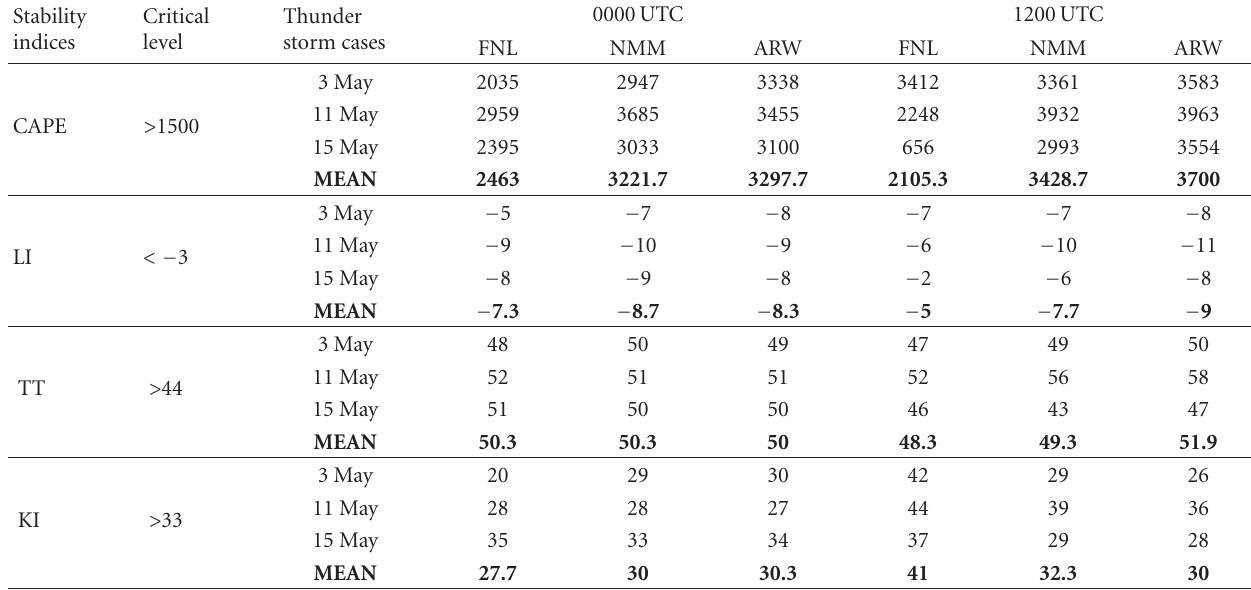
Table 3: Comparison of NMM- and ARW-model-simulated stability indices with FNL analysis for three thunderstorm events during SAARC STORM field experiment 2009.